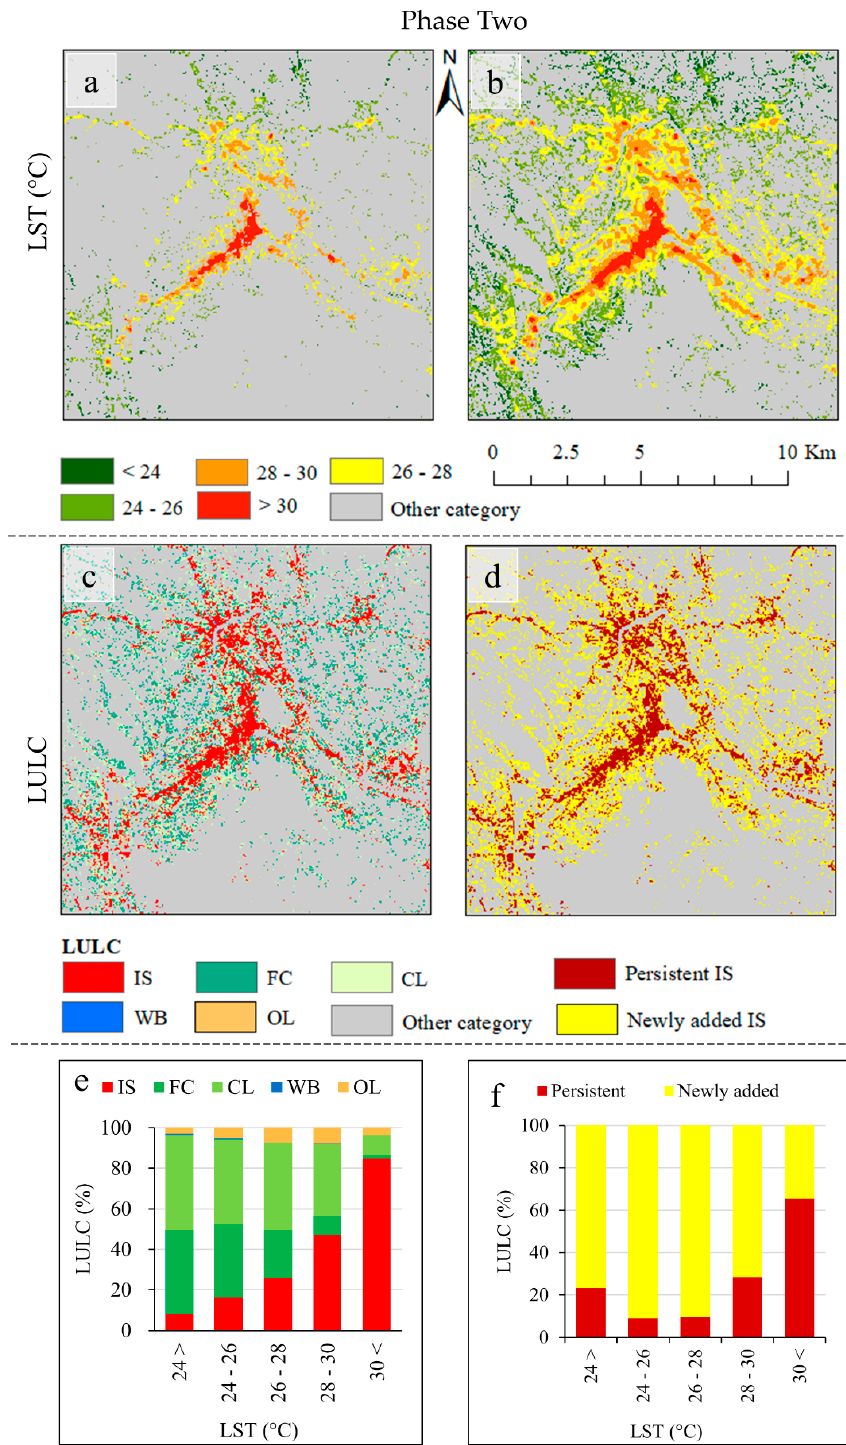
Figure 6. LST spatial and temporal pattern over the LULC in Phase Two: ( a ) LST over IS area in 2006; ( b ) LST over IS area in 2017; ( c ) persistent and newly added IS in 2017 (newly added IS represented with respective LULC in 2006); ( d ) persistent IS and newly added IS in 2017; ( e ) fraction of LULC in 2017 (with respect to Figure 6c) as a percentage by LST classes; ( f ) fraction of persistent and newly added IS in 2017 (with respect to Figure 6d) as a percentage by LST classes. Note: The other category in the legend shows no impervious surface that was not accounted for in this calculation.